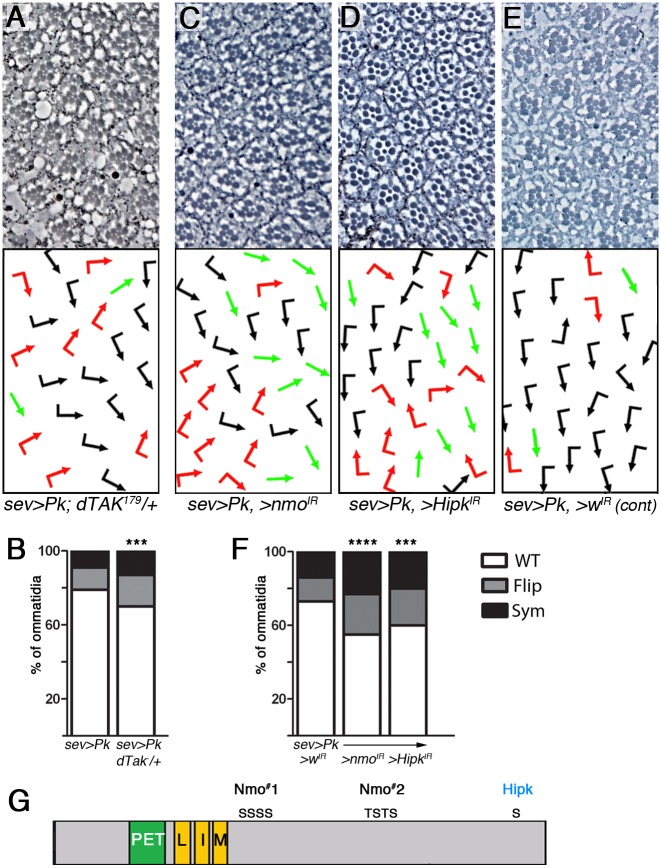
Nmo acts with dTAK and Hipk to regulate Pk.(A-B) The phenotype of sev>Pk is enhanced in a dTAK179 heterozygous background (A), quantified in (B) (See also Figs 5 and 6 for sev>Pk section examples). (C-E) Knockdown of Hipk (D) enhances the sev>Pk, >wIR phenotype (E), similarly to knockdown of nmo (C). (F) Quantification of eye phenotypes in C-E (in each genotype n>200 and P<0.005, and <0.0005 for *** and ****, respectively). (G) A schematic of the Pk protein showing location of the consensus Hipk phosphorylation site S880, within the consensus HESPSR, along with the two clusters of Nmo phosphorylation sites.